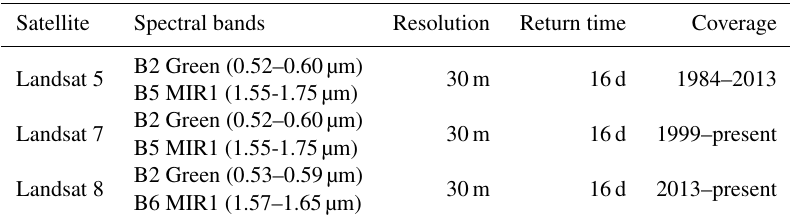
Figure 2. Location and characteristics of the considered water bodies. Table 1. Properties of Landsat data